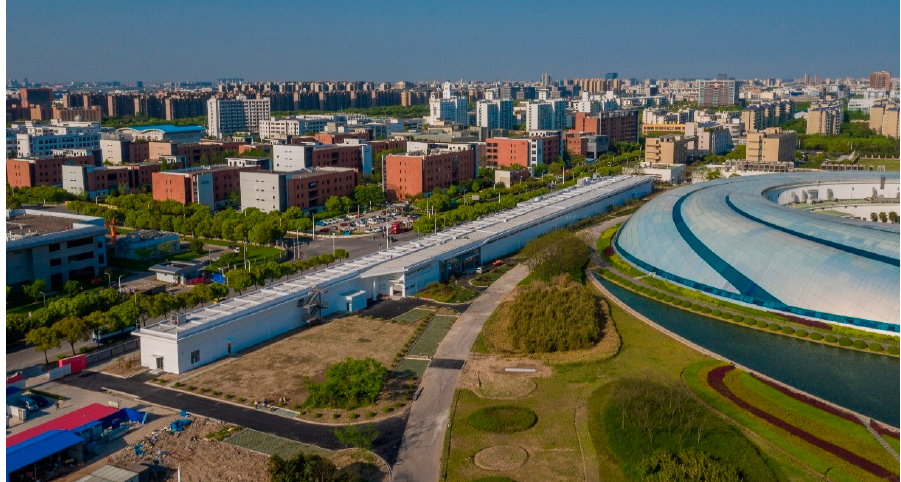
Figure 9. Bird’s eye view of the SXFEL-TF site.